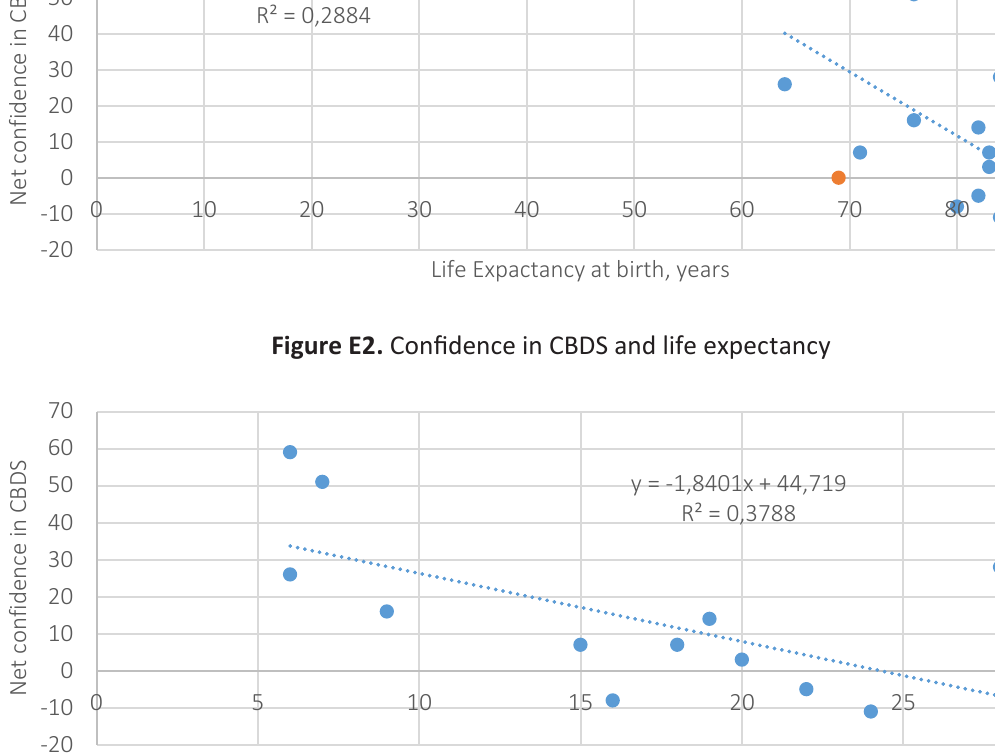
y = -1,7793x + 154,07 R² = 0,2884